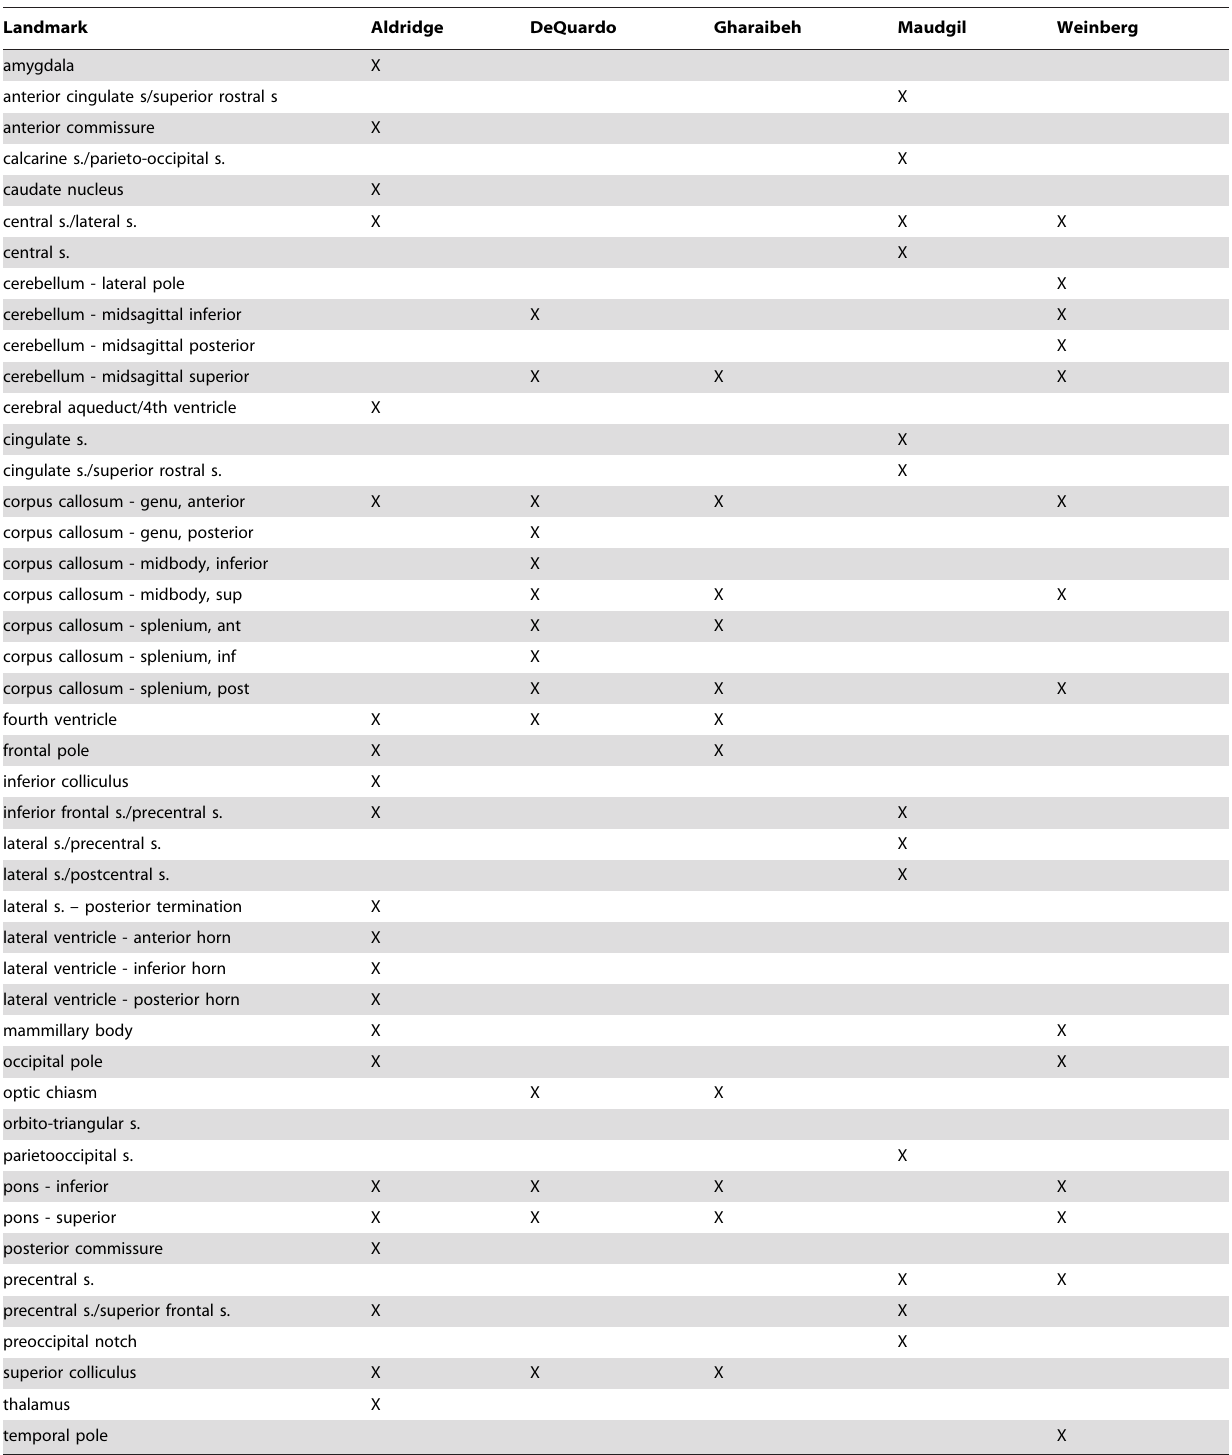
Table 1. Brain landmarks tabulated from the